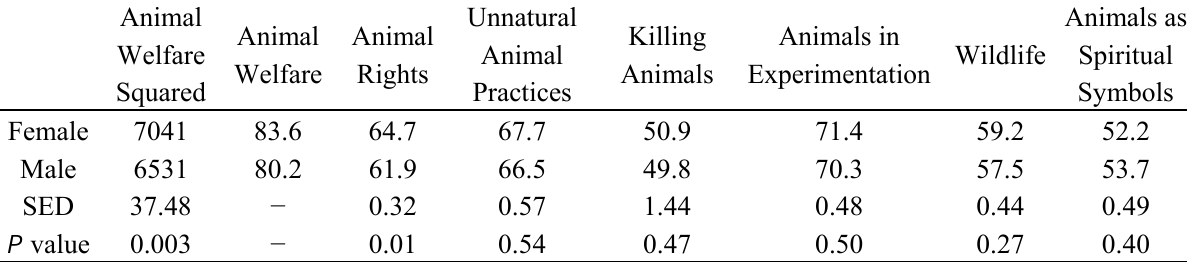
Table 2. Differences between males and females in mean acceptability of issues relating to indices for Animal Welfare, Animal Rights, Unnatural Practices on Animals, Killing Animals, Animals in Experiments, Wildlife, Using Animals as Spiritual Symbols. High values mean greater concern for animals.